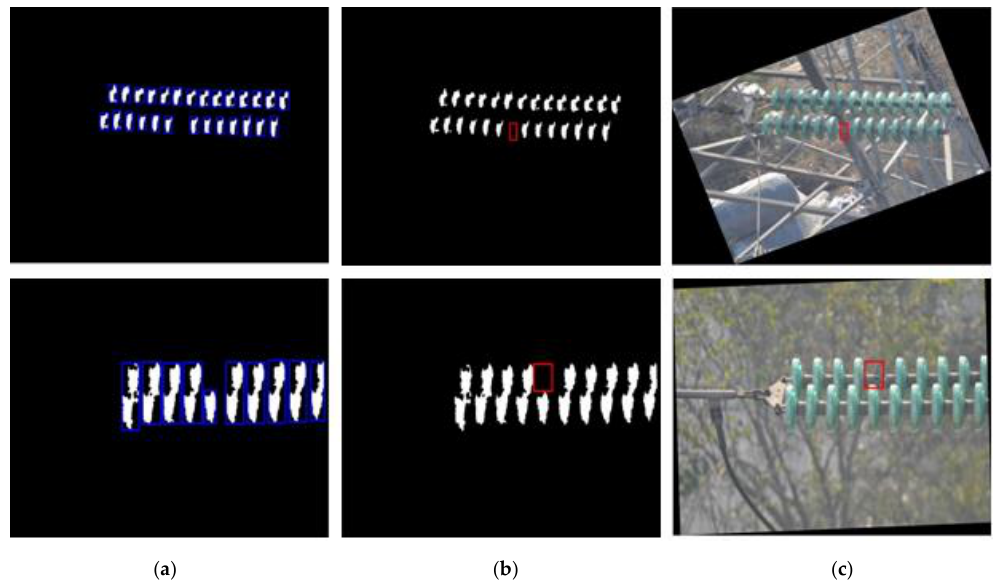
Figure 7. Results of localization: (a) Connected regions of insulators; (b) Self-shattering location; (c) Localization of original image.